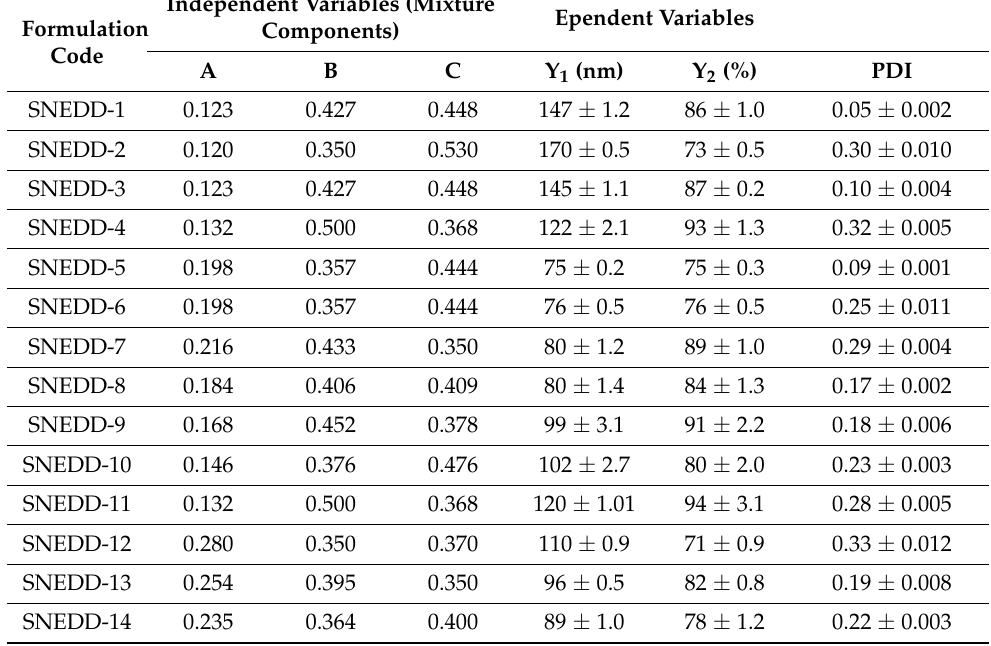
Table 1. Projected trial formulation compositions and observed responses of LV-Eu loaded self- nanoemulsion (SNEDDS) formulations, as recommended by the mixture design.